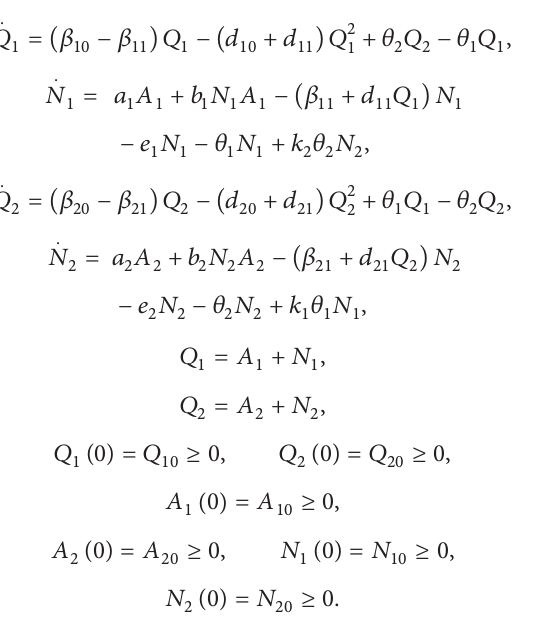
Figure 1. Based on the analysis above, the increase equation of 𝑄 1